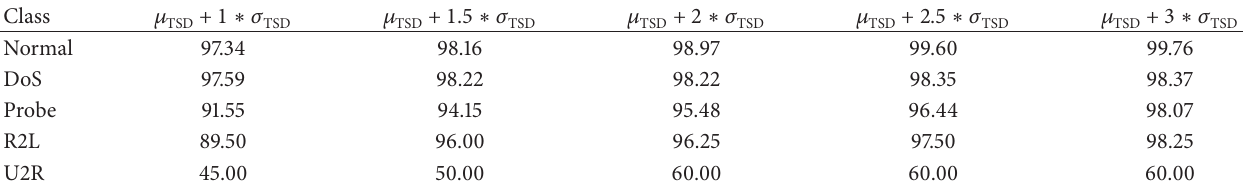
Table 5: Average detection rates (%) of different models with 10-fold cross validation technique.